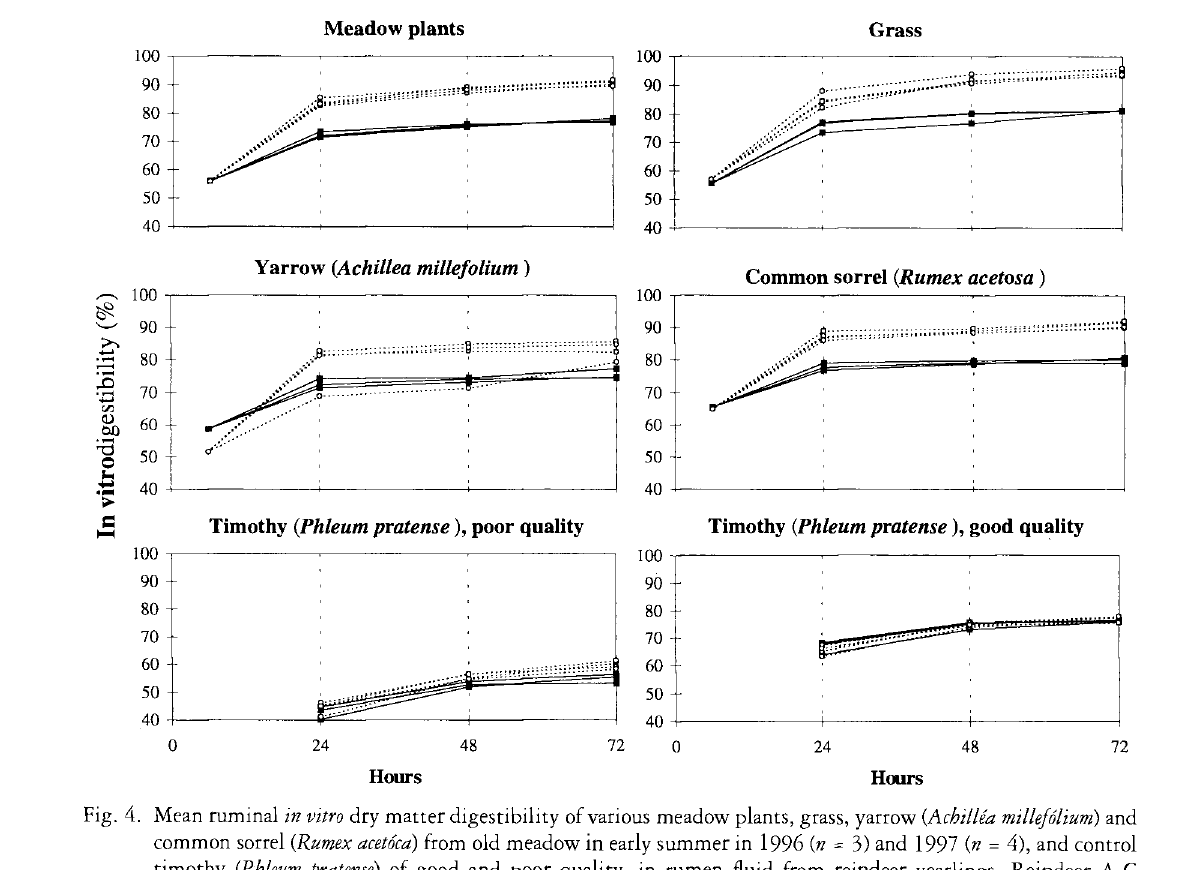
Fig. 4. Mean ruminal in vitro dry matter digestibility of various meadow plants, grass, yarrow (Achillea millefolium) and common sorrel (Rumex acetoca) from old meadow in early summer in 1996 (n = 3) and 1997 (n = 4), and control timothy (Phleum pratense) of good and poor quality, in rumen fluid from reindeer yearlings. Reindeer A-C 1996 -B-; -G1997